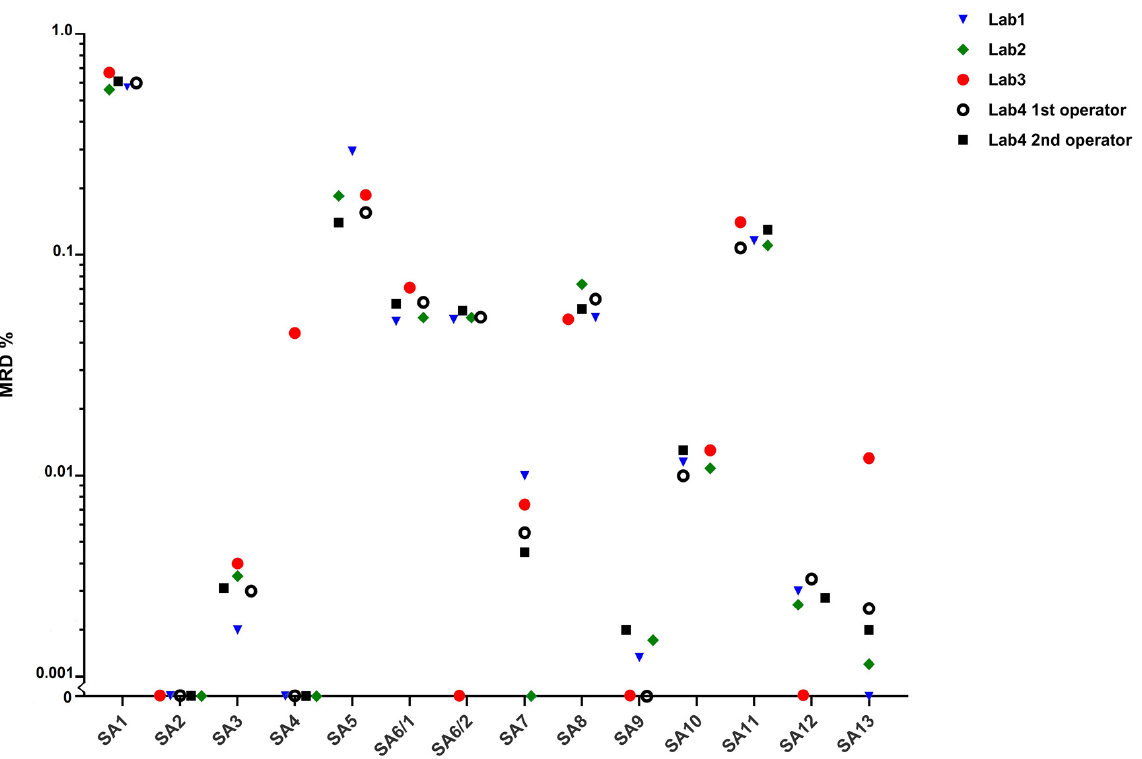
Figure 3. Results of inter-operator analysis variability study. Case SA6 with two different abnormal plasma cell populations, each accounted for >0.01% nuclear cells. Cases SA2 and SA4 did not contain pathological plasma cells.